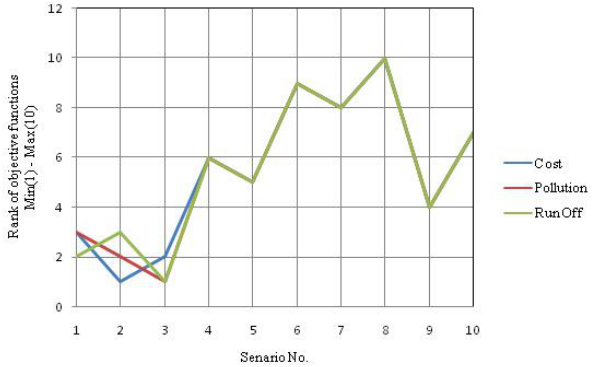
Fig. 10. Comparison of scenarios based on the rank of objective functions.